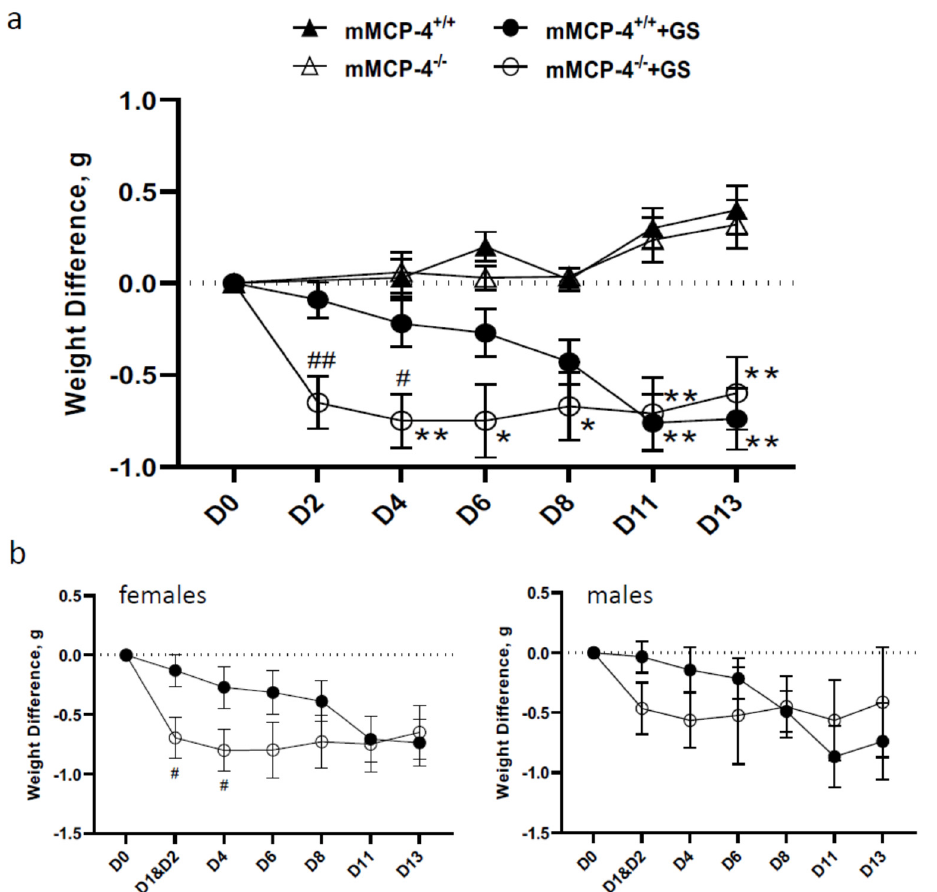
Figure 1. Weight loss in mMCP-4 − / − mice infected with Giardia intestinalis . Mature adult (18–36 weeks) congenic mMCP-4 +/+ , mMCP-4 − / − C57Bl / 6 littermate mice without antibiotic treatment were infected